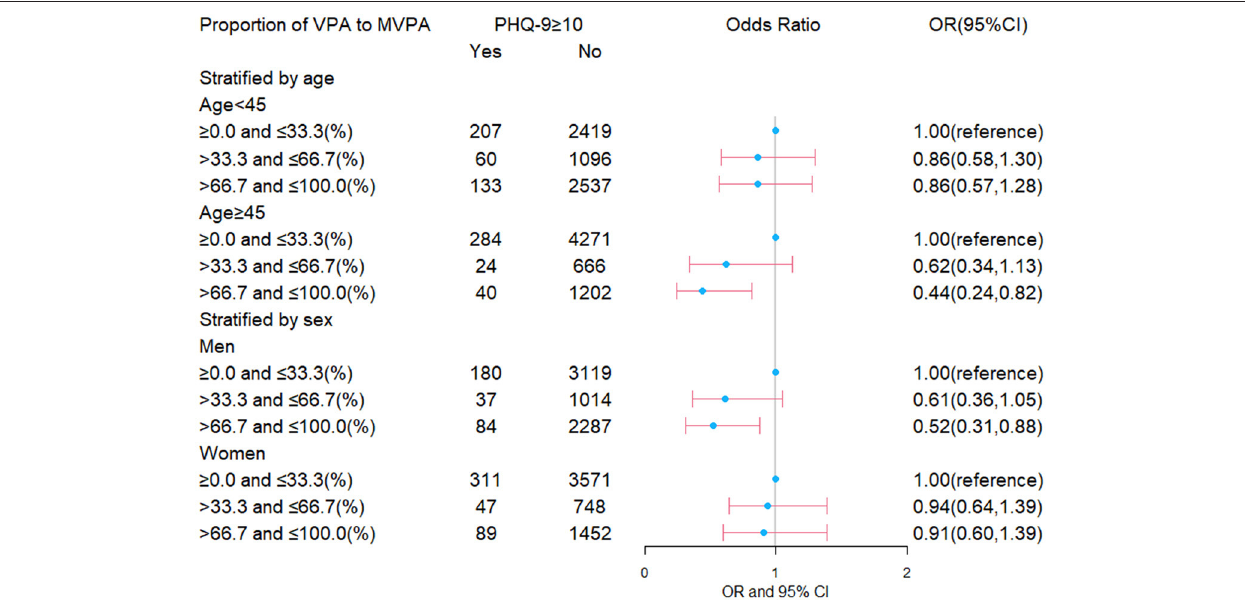
FIGURE 1 | Correlation between the proportion of VPA to MVPA and the risk for depression among groups separated by age and sex. VPA, vigorous physical activity; MVPA, moderate-to-vigorous physical activity; PHQ-9, Patient Health Questionnaire-9; OR, odds ratio; CI, confidence